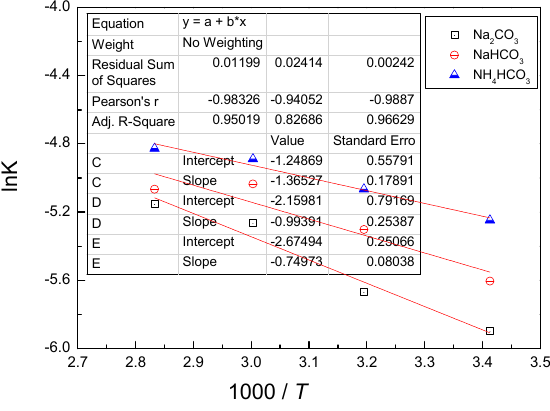
Figure 9. Relation between the concentration of leaching agent and the synthesis reaction rate.